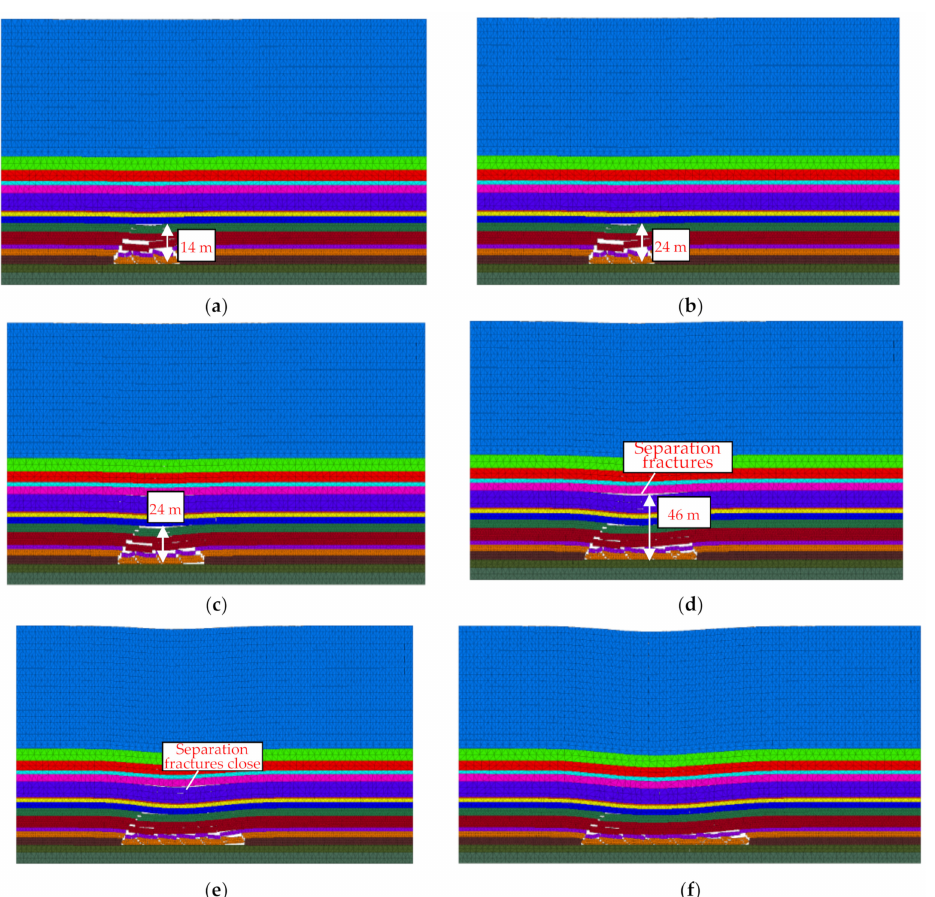
Figure 2. Caving characteristics. ( a ) The working face advances to 40 m. ( b ) The working face advances to 60 m. ( c ) The working face advances to 80 m. ( d ) The working face advances to 100 m. ( e ) The working face advances to 120 m. ( f ) The working face advances to 140